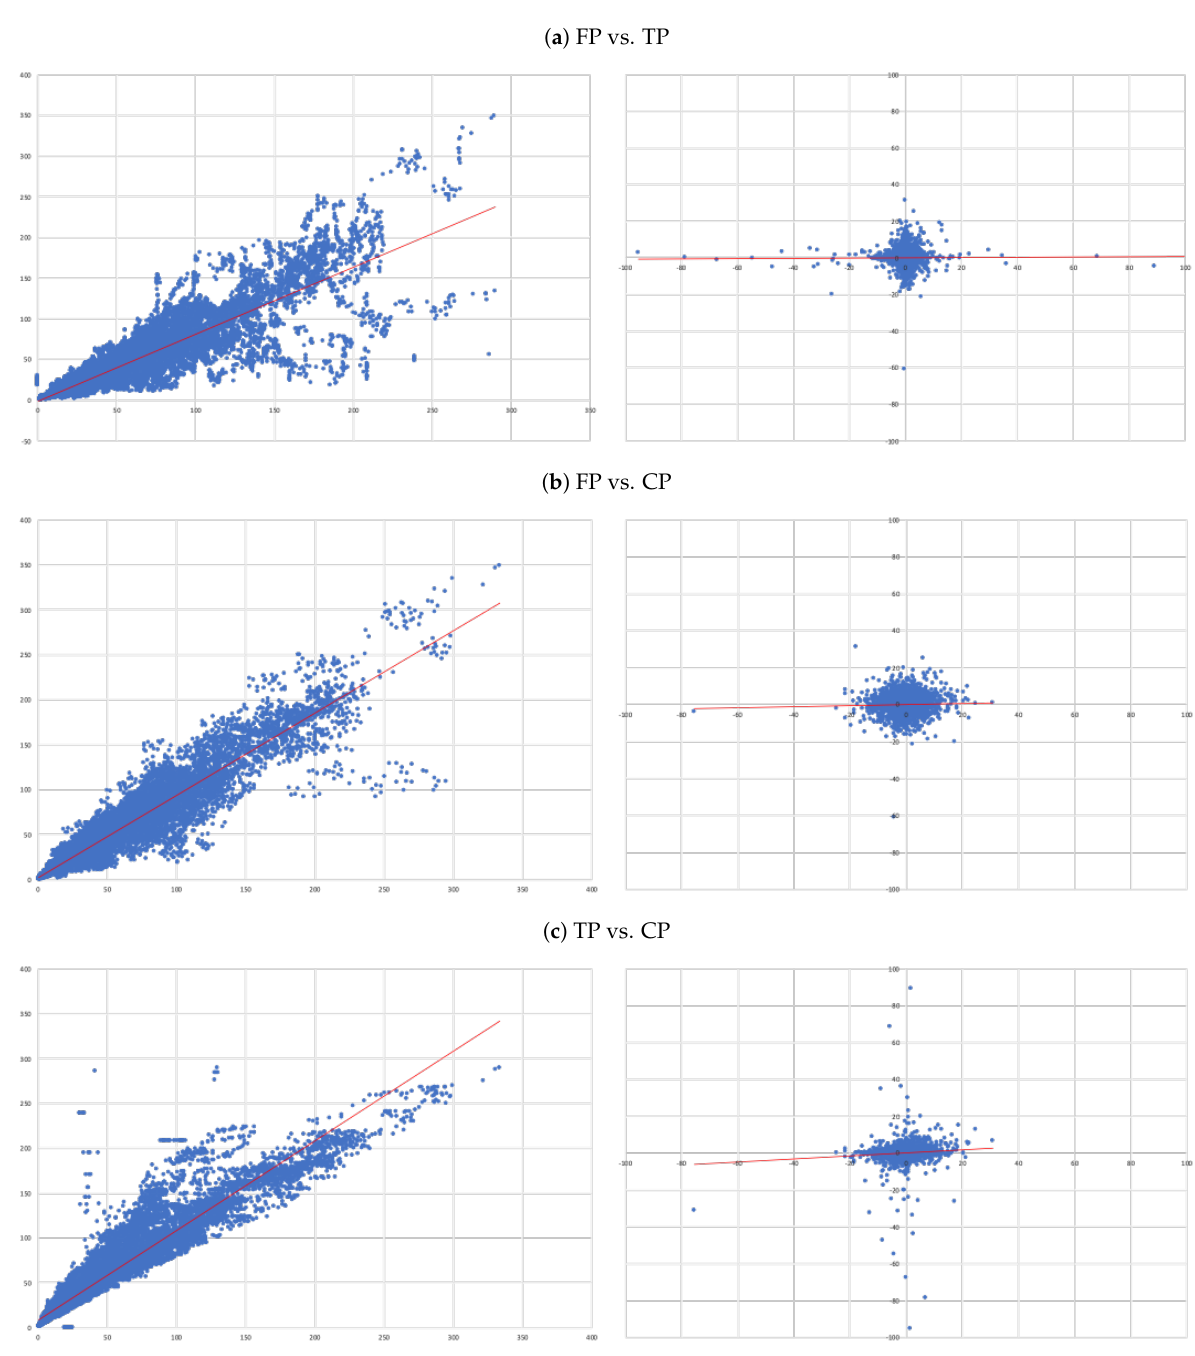
Figure 2. Panel regressions’ illustration. Illustration of the panel regressions of Table 3. On the left-hand-side are images of level regressions and on the right-hand–ide are regressions in